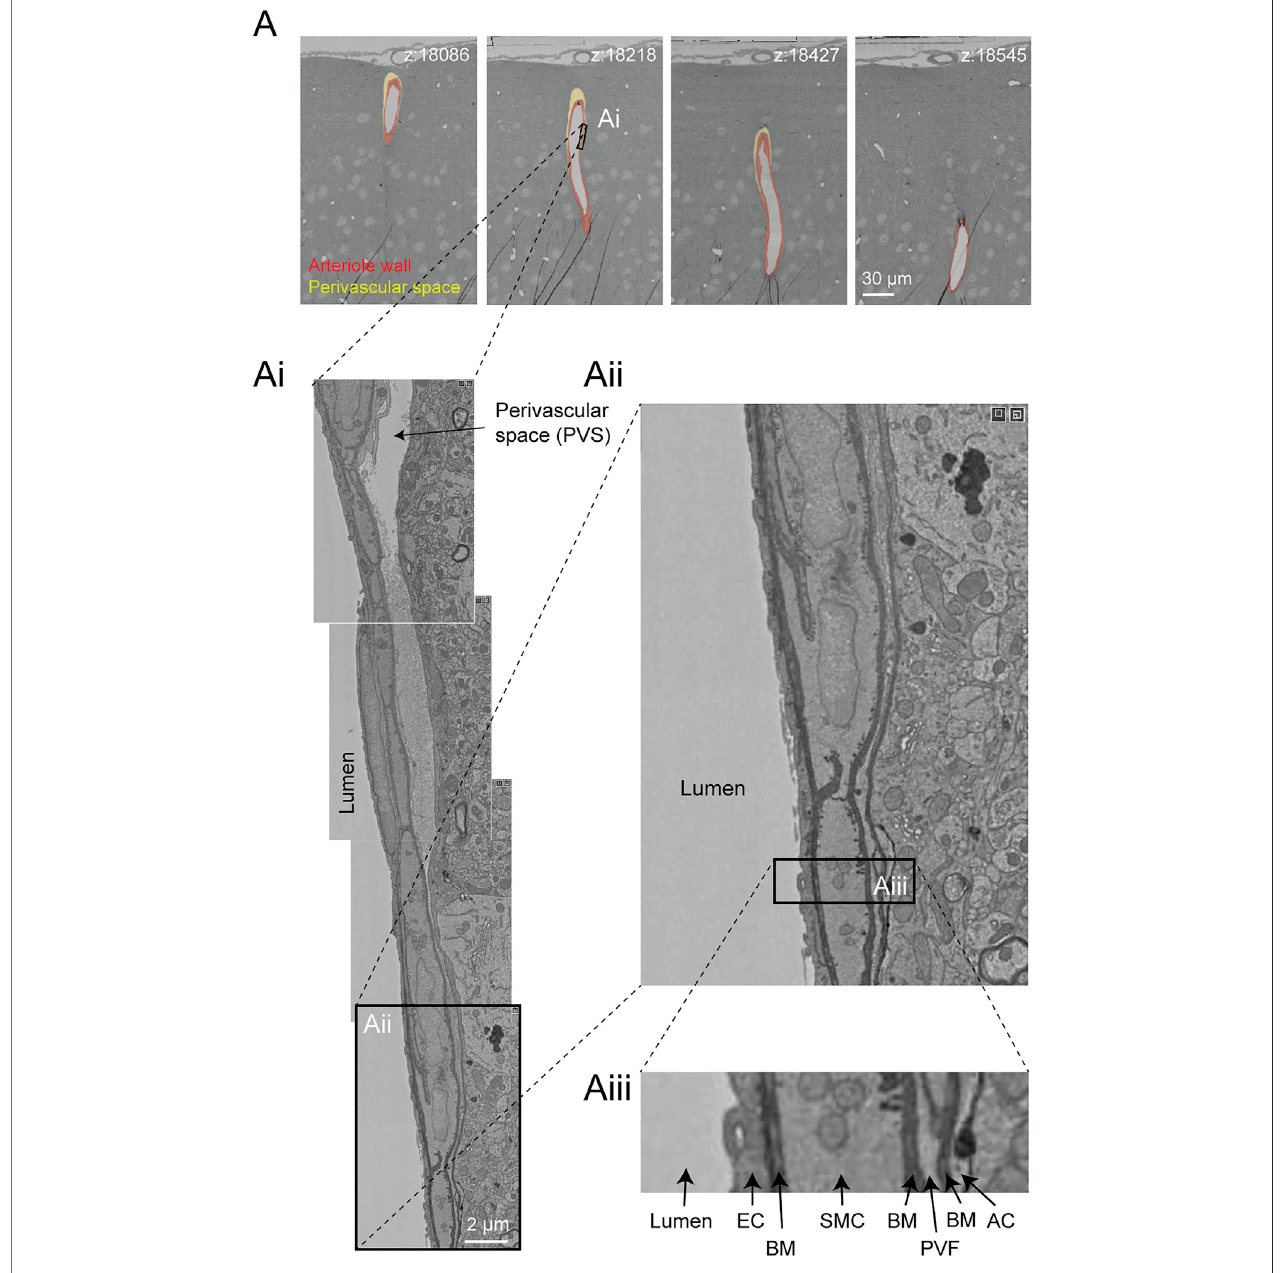
FIGURE9| Perivascular space and layersof thearteriole wall. (A) A large penetrating arterioleinthe MICrONS Cortical MM ^ 3 dataset exhibitsaclear perivascular space. (Ai) Magni fi ed view of the arteriole wall showing the perivascular space diminishing in size with greater cortical depth. (Aii, Aiii) Magni fi ed view showing layers of the arteriole wall, revealing that the perivascular space becomes continuous with the perivascular fi broblast layer as the perivascular space diminishes. EC — endothelial cell, BM — basement membrane, SMC — smooth muscle cell, PVF — perivascular fi broblast, AC — astrocyte. Coordinates of the penetrating arteriole: